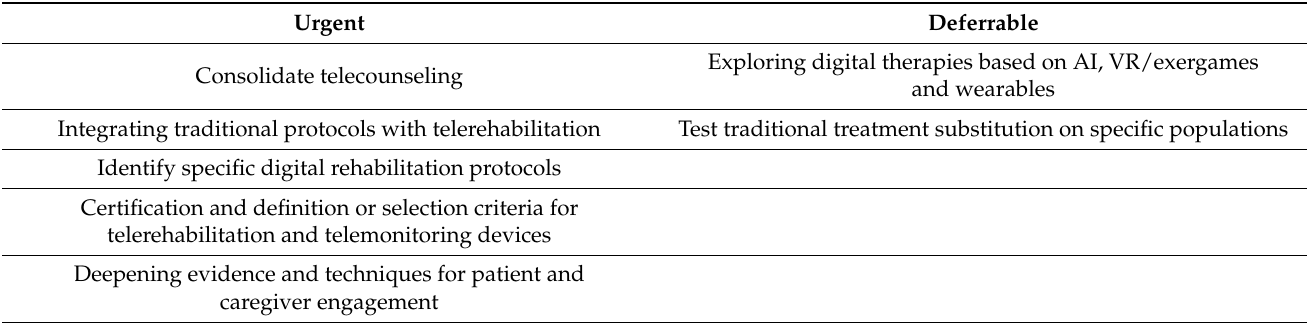
Table 3. Priorities on pediatric telerehabilitation